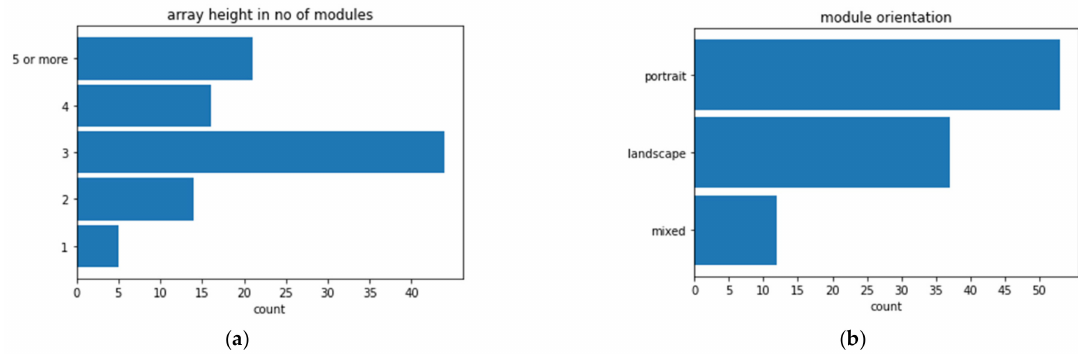
Figure 3. Histograms on the characteristics of the survey sites: ( a ) the number of module rows in the PV array height and ( b ) the orientation of the modules in the PV